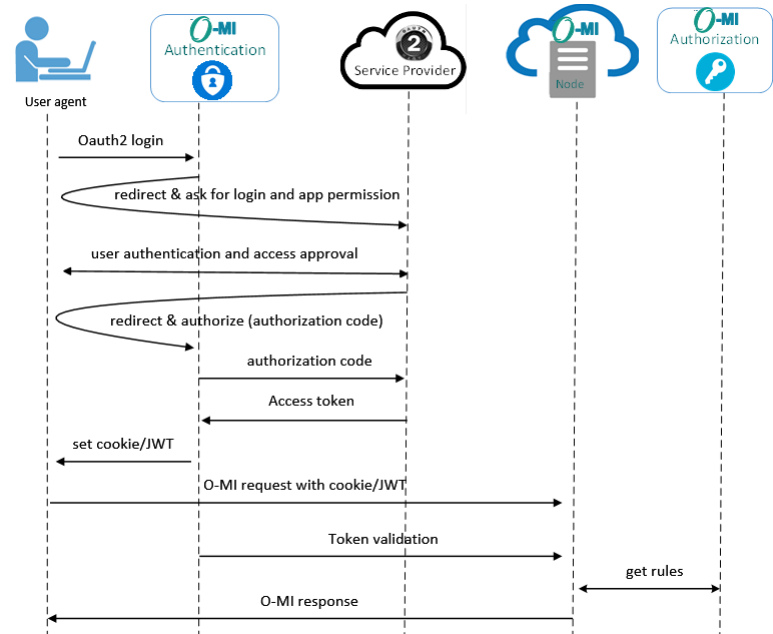
Figure 9. OAuth2